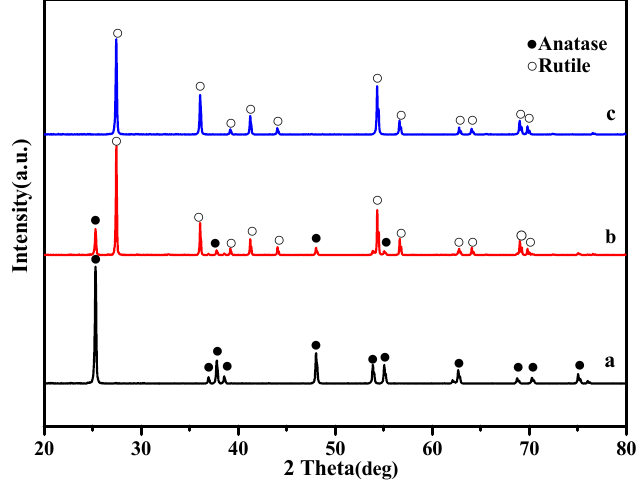
Figure 10. XRD patterns of ( a ) TiO 2 , ( b ) fresh MnTi catalyst, and ( c ) reduced MnTi catalyst.